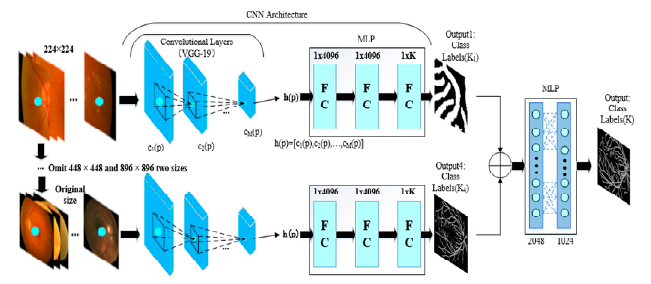
Figure 1. The structure of multi-seg convolutional neural network (CNN).